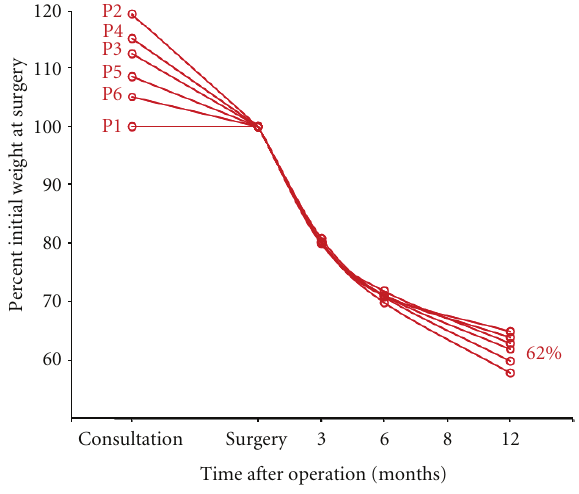
Figure 6: Hypothetical regression model. This model demonstrates the e ff ect of preoperative weight loss in gastric bypass